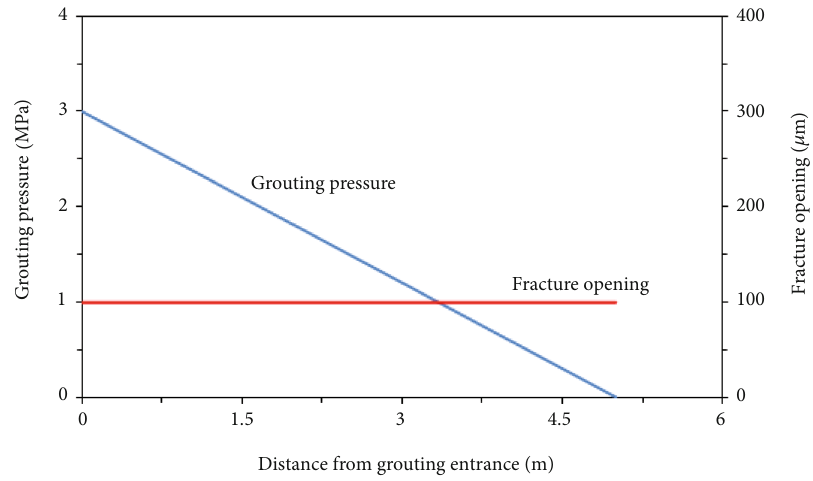
Figure 6: The curve of grouting pressure and fracture opening with no fl uid-solid coupling.